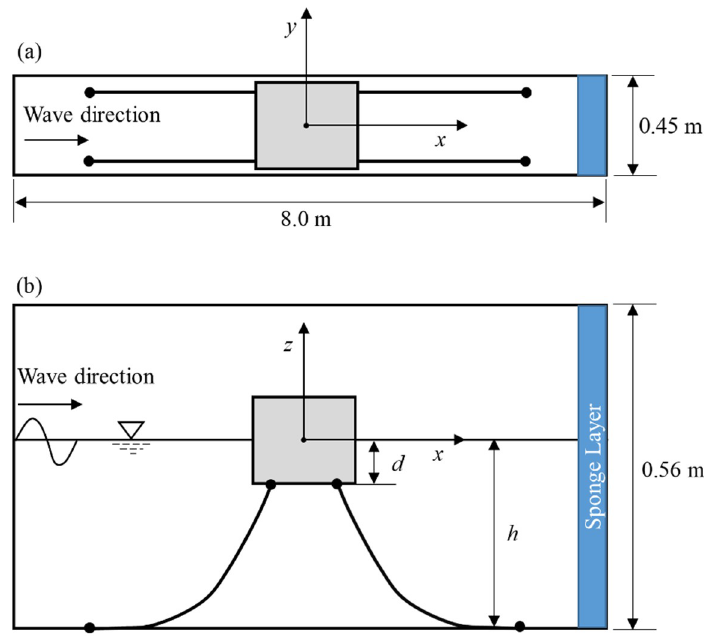
Figure 9. The schematic computational domain for a moored floating box in waves (( a ): top view; ( b ): side view).